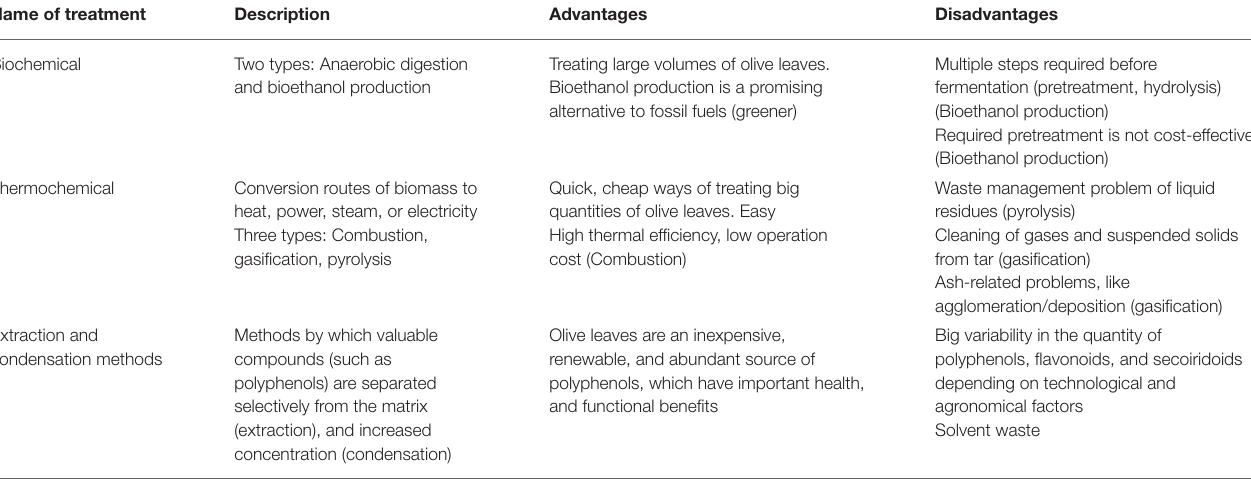
TABLE 4 | Treatments for olive leaves with corresponding description, advantages, and